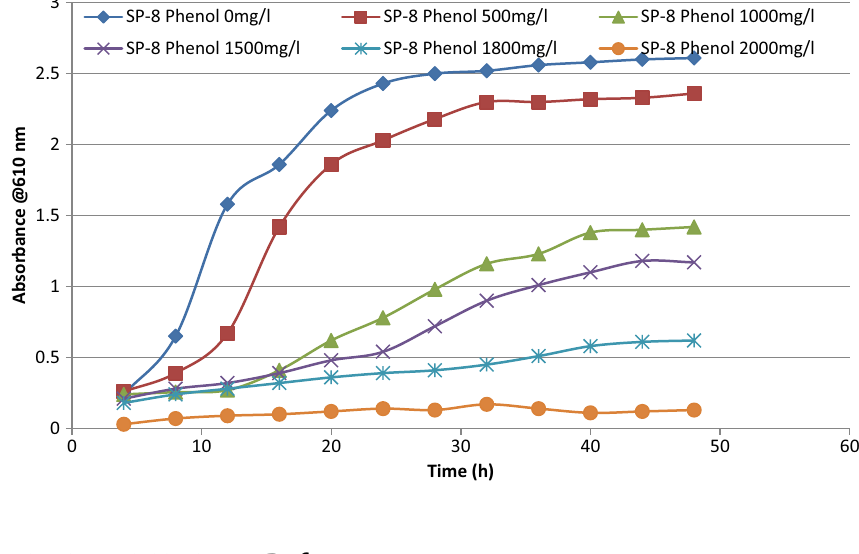
Fig. 3 Growth study of SP-8 at different concentrations of phenol (0–2000